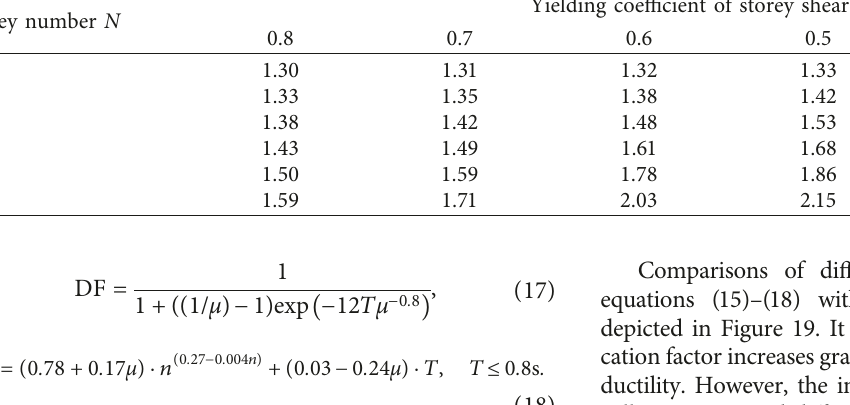
Figure 15: Influence of ground acceleration records (GA): (a) 5-storey structure ( T � 0.30s) and (b) 6-storey structure ( T � 0.36s). Table 5: Estimated values of η p for seismic